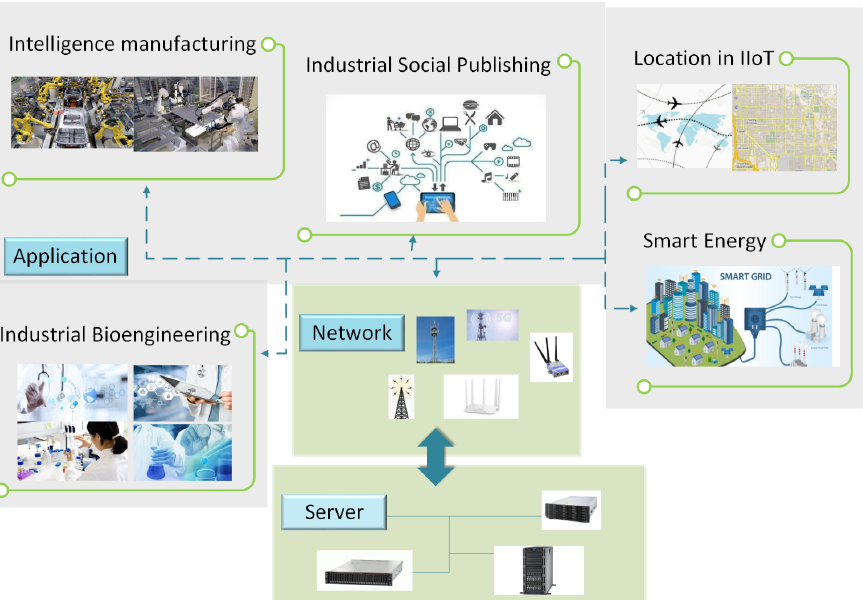
Figure 9. A motivating network deployment of IIoT. The wireless devices, sensors and equipments installed with EE-MPTCP can exchange information with each other using their WiFi and 4G/5G interfaces, and can also communicate with remote